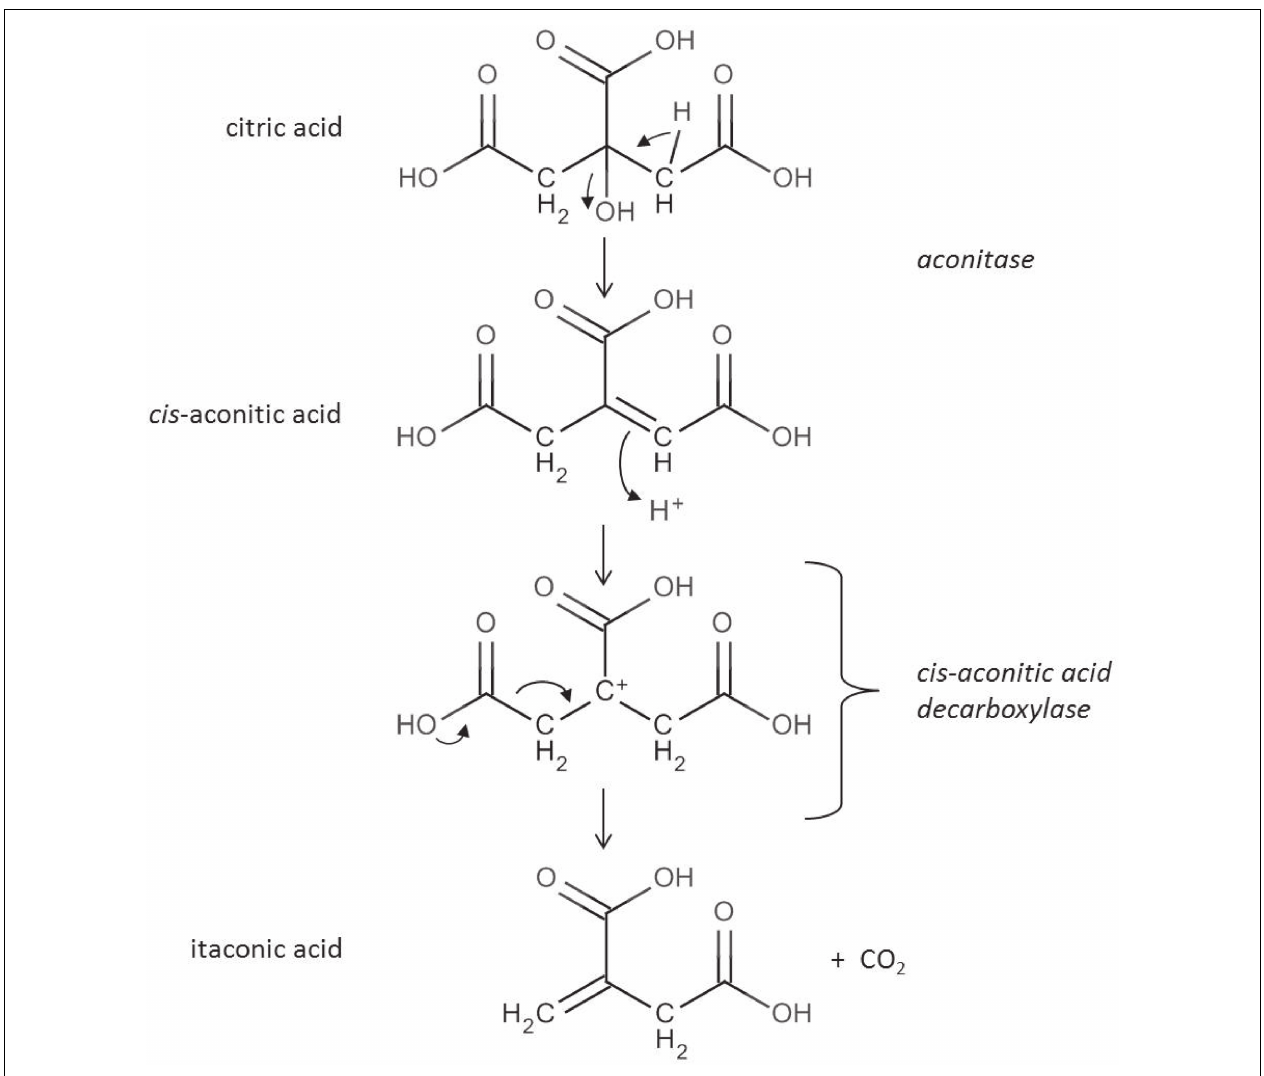
FIGURE 2 | In the citric acid cycle cis- aconitic acid is formed as an intermediate during the conversion of citric acid to isocitric acid. cis- aconitic acid is decarboxylated by the CadA enzyme to itaconic acid releasing CO 2 (Bentley andThiessen,